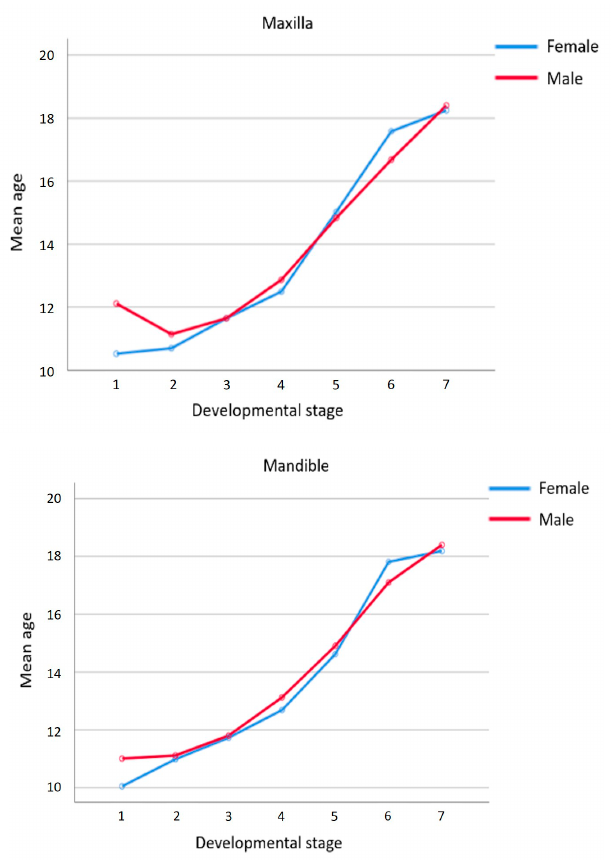
Figure 2. Mean comparison between males and females in the maxilla ( upper ) and mandible ( lower ). No statistical significance found between males and females regarding developmental stage difference.